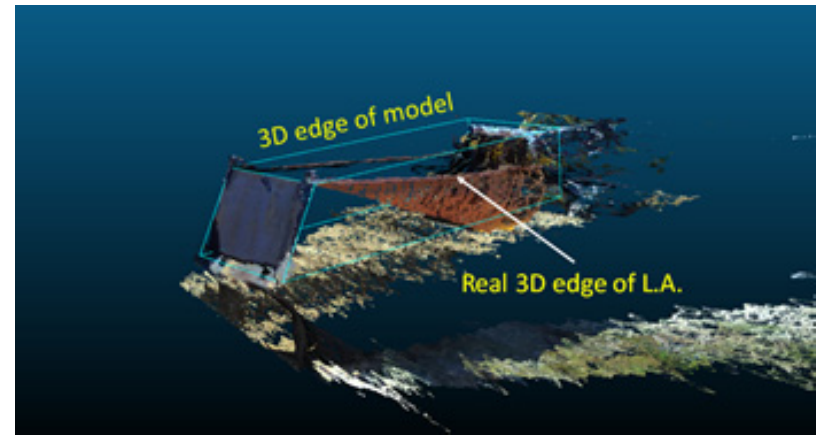
Figure 14. Example of initial 3D position and error of the truck cargo box.